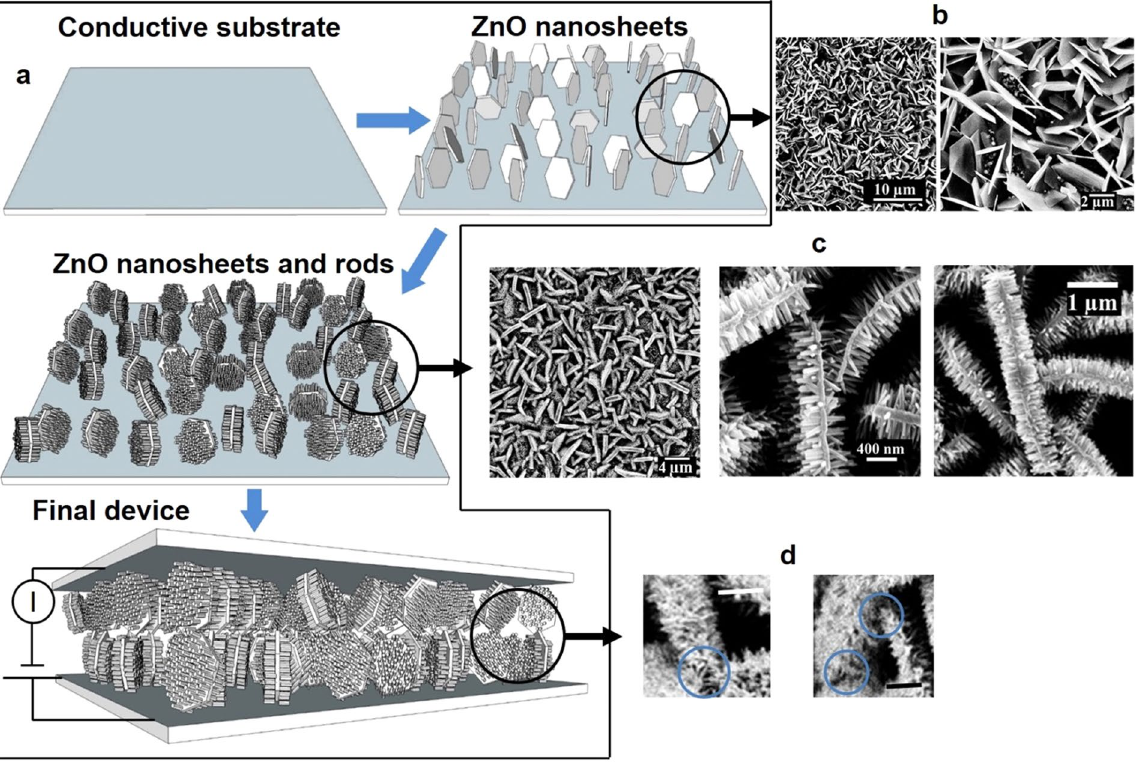
Figure 1. ( a ) Schematic showing the formation of the device structure. ( b ) FESEM images showing the ZnO sheets that form the first layer of the device. The higher resolution image on the right shows that the sheets are microns in size with a thickness on the scale of 50–200 nm. ( c ) FESEM images of the sheet-rod nanostructure. The image on the left shows the high density of the structure. The higher resolution images on right clearly show the sheet outline and the rods growing primarily on the larger area plane of the sheets. The length of the rods is 200–400 nm. ( d ) The cross section of the final device structure shows the interlocking between the sheet-rod nanostructure of the top and bottom electrode. This has been highlighted in blue. The scale bars are 1 µ